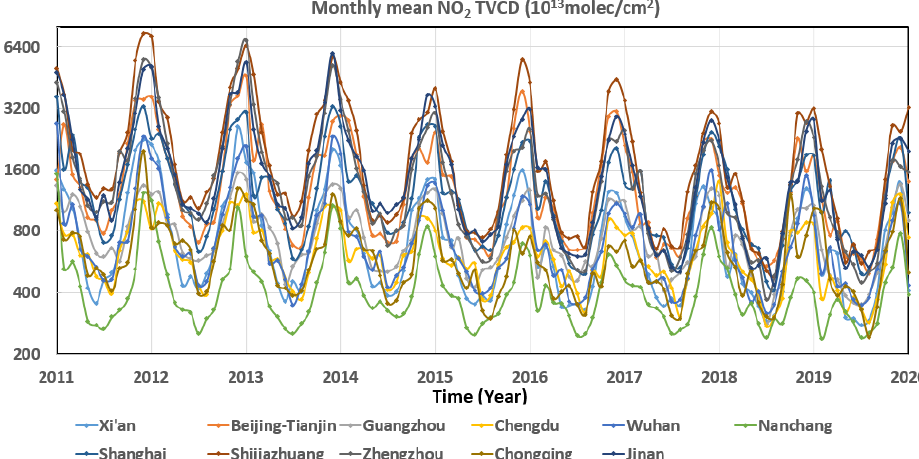
Figure 2. Time series of monthly-mean NO 2 TVCDs derived from OMI data, for 11 regions from January 2011 to December 2019. The NO 2 TVCDs are plotted on a logarithmic scale to better visualize the differences between different regions as well as the gradual variation of the TVCDs during the summer months.